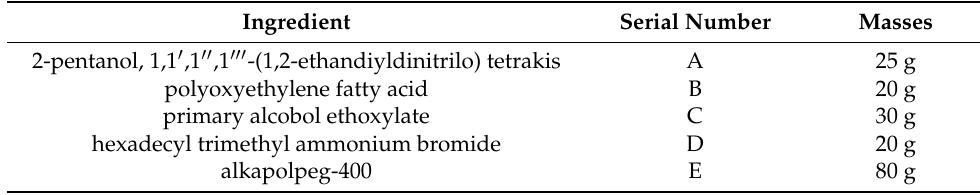
Table 1. The formulation of OAA.